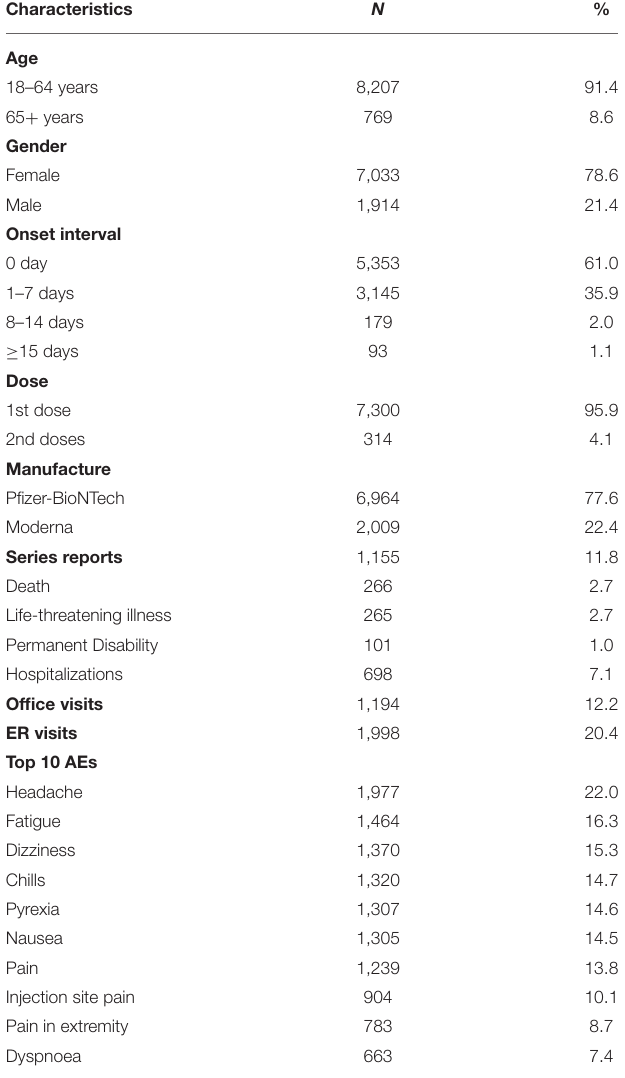
TABLE 1 | Characteristics of adults with VAERS reports following COVID-19 vaccination ( N = 8,976).